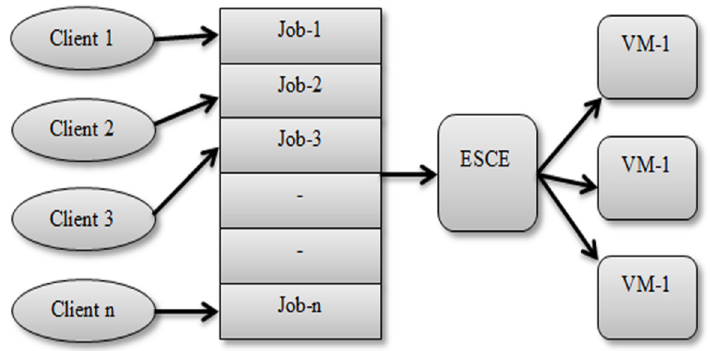
Figure 2. The process of the ESCE algorithm [1].